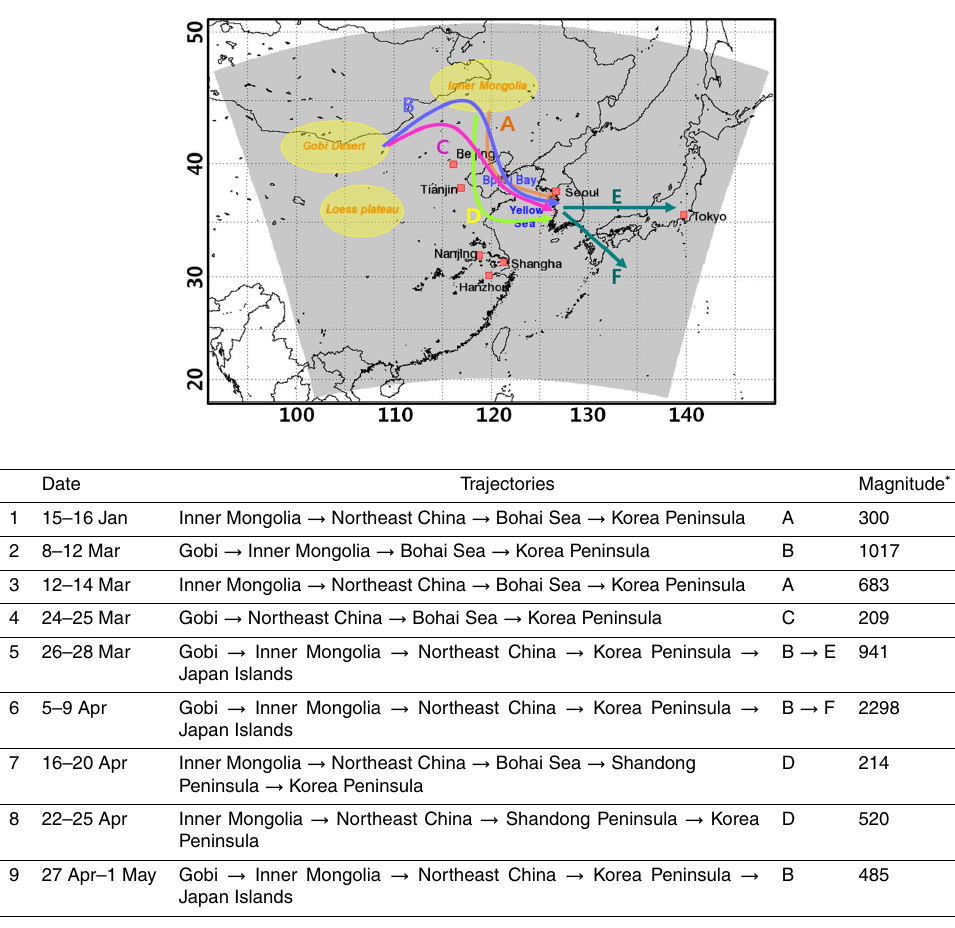
∗ Magnitude represents the maximum concentration of PM Fig. 2. Modeling domain (grey-shaded area) of this study, and the trajectories and magnitudes of 9 major dust events that occurred in spring,